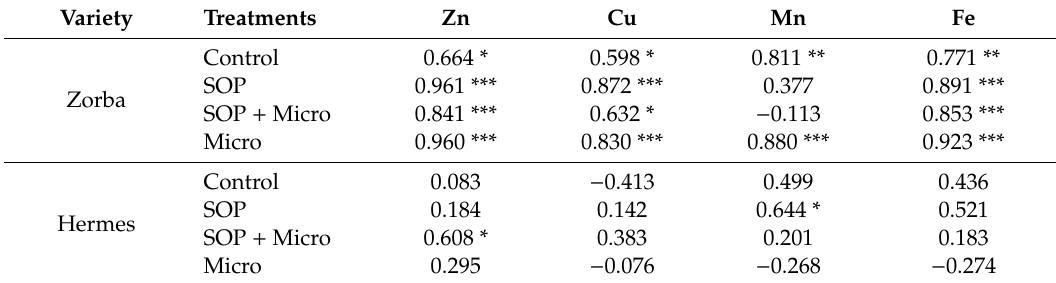
Table 3. Correlation analysis for the relationships between tuber yield and microelement uptake by potato.